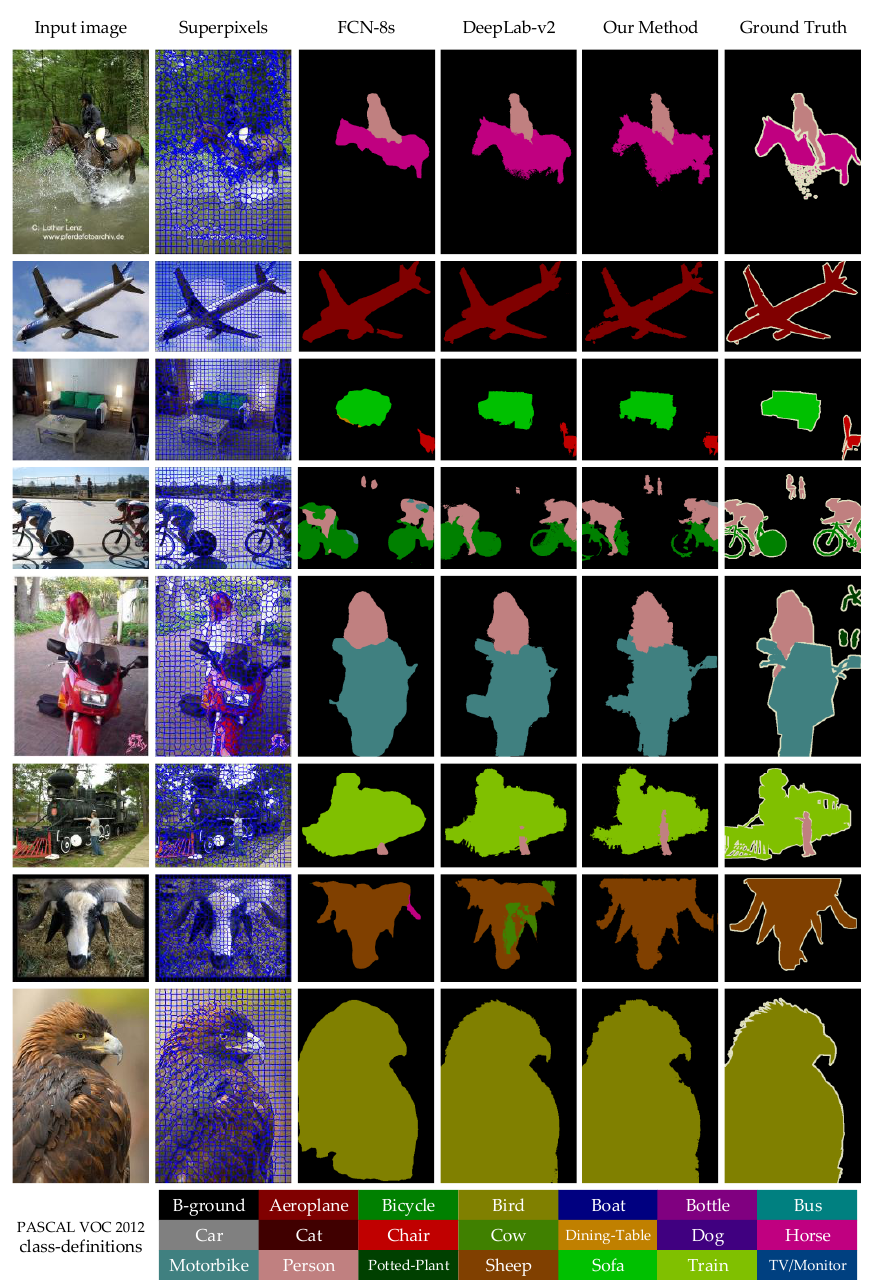
Figure 10. Qualitative results on the reduced validation set of PASCAL VOC 2012. From left to right: the original image, SLIC segmentation, FCN-8s results, DeepLab-v2 results, our results, and the ground truth.